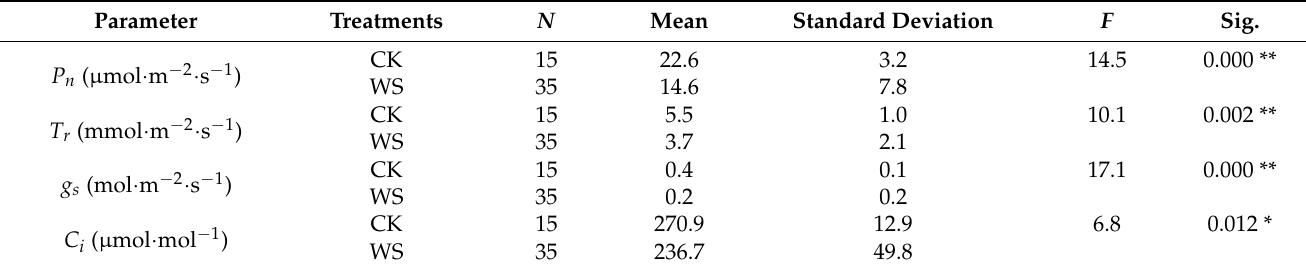
Table 1. One-way ANOVA of photosynthetic physiological parameters of spring wheat leaves under different soil water